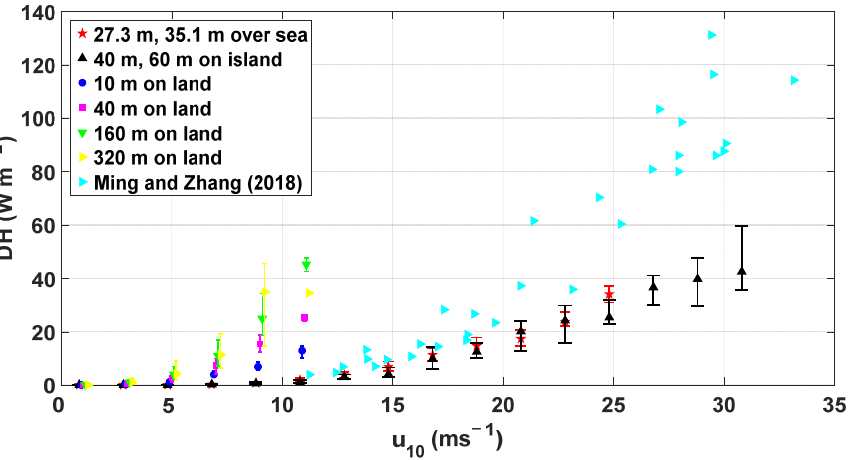
Figure 10. The same as Figure 8 except for the dissipative heating ( DH ) as a function of 10 m wind speed ( 𝑢 (cid:2869)(cid:2868) ).